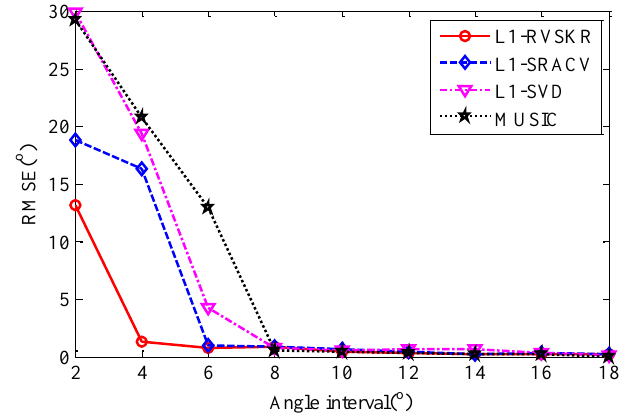
Figure 4. RMSE of DOA estimation versus the angle interval.